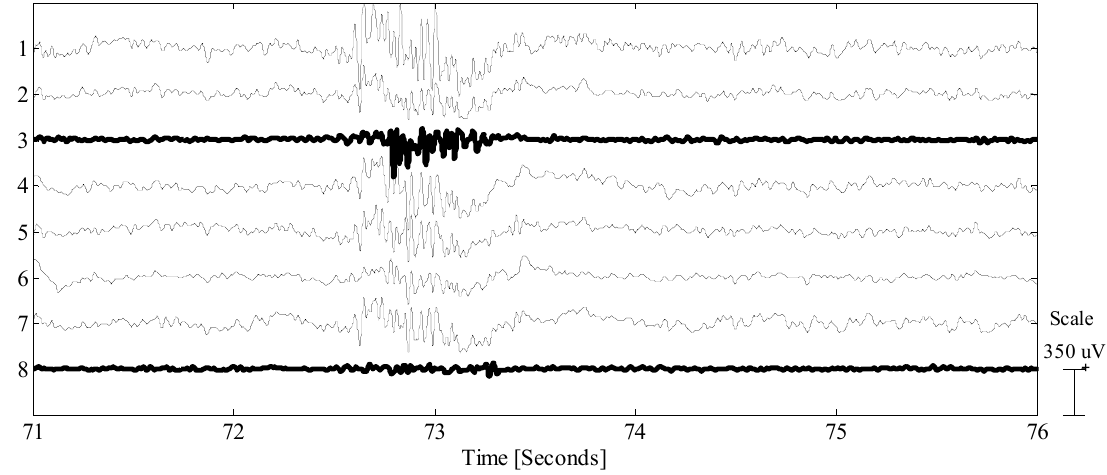
Figure 6. EEG data excerpt including a jaw artifact. Bold traces mark the two electrodes not in good contact. Please note how the scalp-shifts during the artifacts are sufficient to achieve some contact at least for channel 3, which displays a physiological signal only during the artifact.